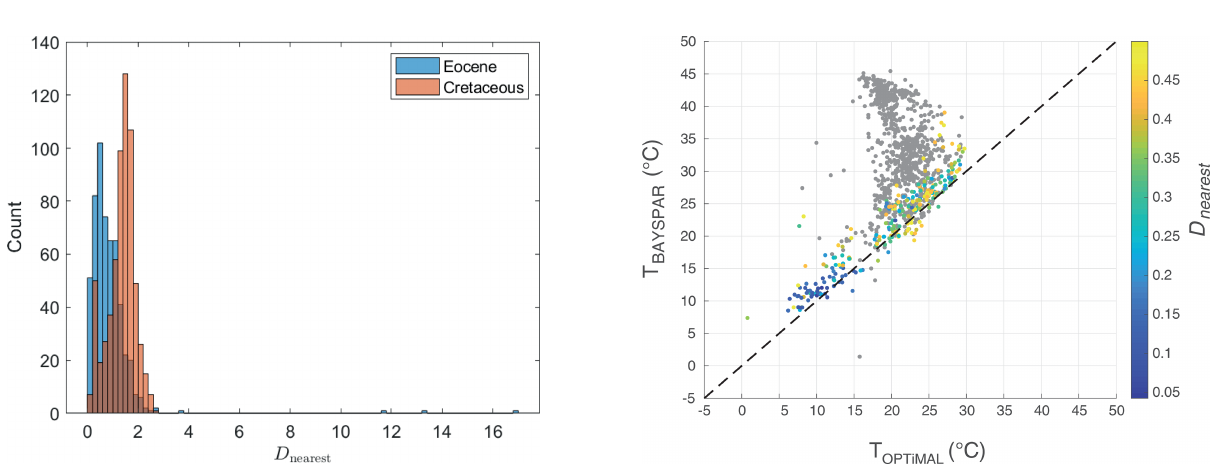
Figure 13. Comparison of temperature estimates for the BAYSPAR and the OPTiMAL GPR model. Greyed-out data fails the D nearest test ( > 0.5), and the colour scaling reflects D nearest values for those data points that pass. Note that outside of the constraints of the modern calibration (training) dataset ( D nearest test > 0.5) the GPR model temperature estimates revert to the mean value of the calibra- tion dataset, with an uncertainty that reverts to the standard devia- tion of the training